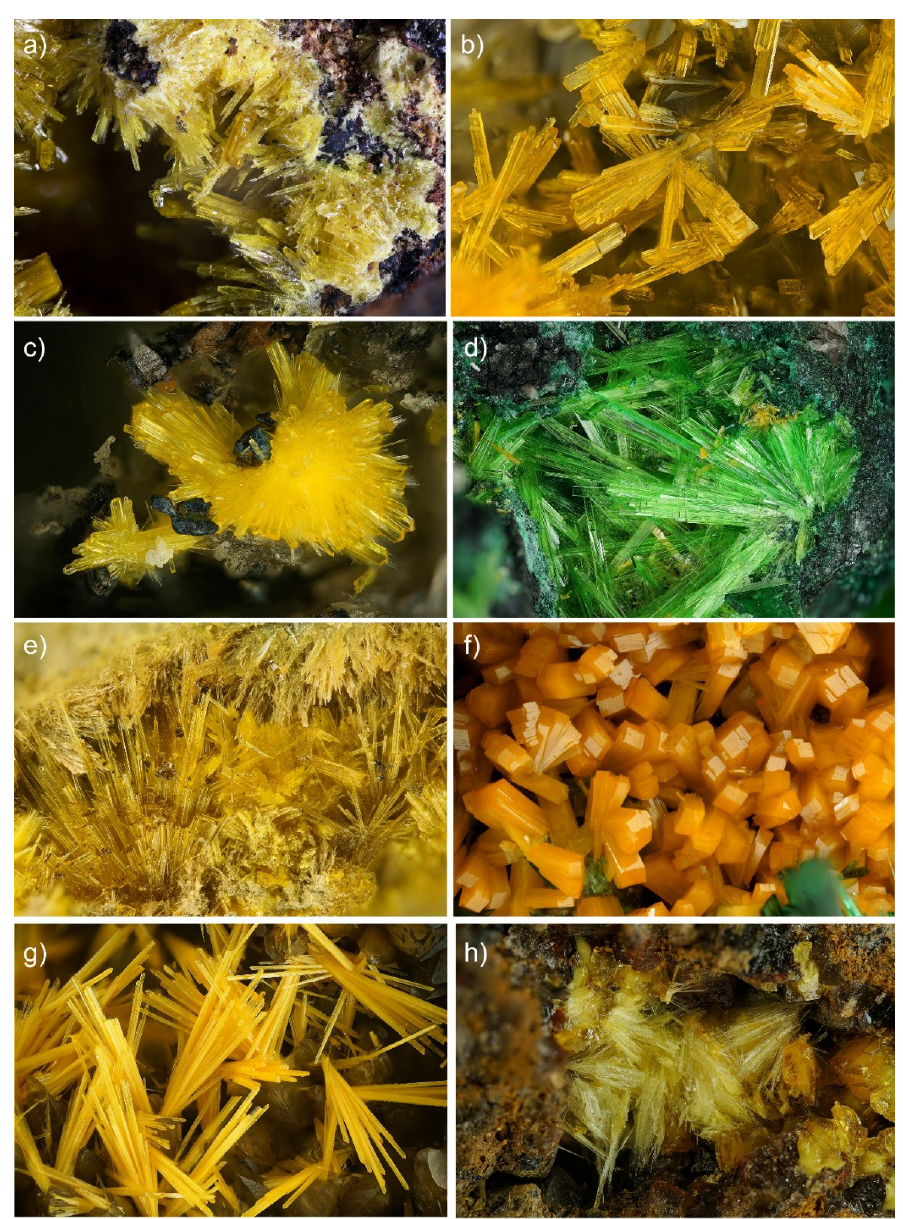
Figure 2. ( a ) Prismatic crystals of uranophane-α in a vug of quartz-dominated gangue from the locality Swambo (Katanga province, Democratic Republic of Congo (DRC), Africa). Horizontal field of view (FOV) is 5.4 mm (photo P. Škácha). ( b ) Typical crystals of uranophane-β from the Rössing mine (Erongo, Namibia, Africa). Horizontal FOV is 5 mm (photo S. Wolfsried). ( c ) Crystals of sklodowskite on a quartz matrix from Kamoto-East open pit (Katanga province, DRC, Africa). Horizontal FOV is 5 mm (photo S. Wolfsried). ( d ) Cuprosklodowskite crystals a vug of Se-digenite rich matrix from the Musunoi mine (Katanga province, DRC, Africa). Horizontal FOV is 6 mm (photo S. Wolfsried). ( e ) Long needle-like oursinite crystals associated with becquerelite (orange) and rutherfordine (pale) from the Shinkolobwe mine (Katanga province, DRC, Africa). Horizontal FOV is 5 mm (photo S. Wolfsried). ( f ) Thick prismatic crystals of kasolite from the Musunoi mine (Katanga province, DRC, Africa). Horizontal FOV is 4 mm (photo S. Wolfsried). ( g ) Long prismatic crystals of boltwoodite from Goanicontes claim (Erongo, Namibia, Africa). Horizontal FOV is 14 mm (photo S. Wolfsried). ( h ) Fine thin prismatic crystals of swamboite-(Nd) in a vug with dipyramidal orange soddyite from the Swambo mine (Katanga province, DRC, Africa). Horizontal FOV is 3 mm (photo S.